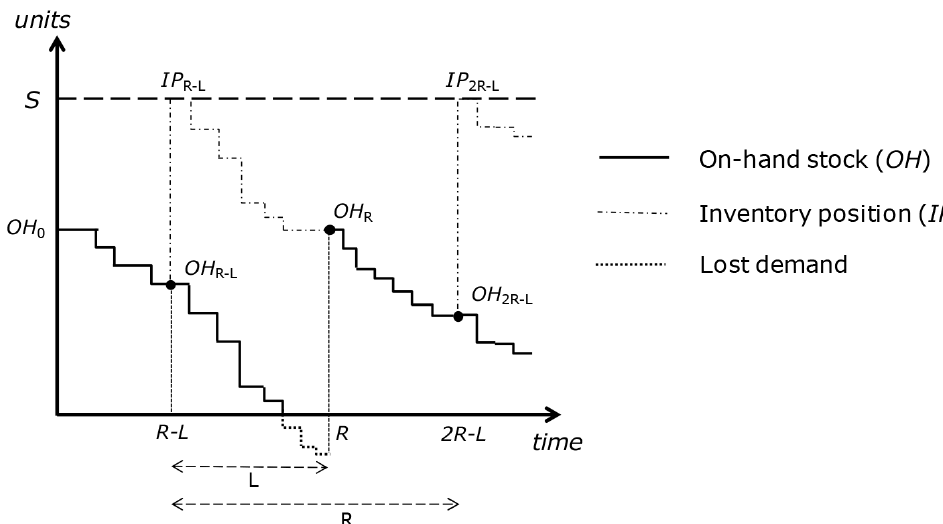
Figure 1. On-hand stock and inventory position evolution in a periodic review ( R, S ) system with lost